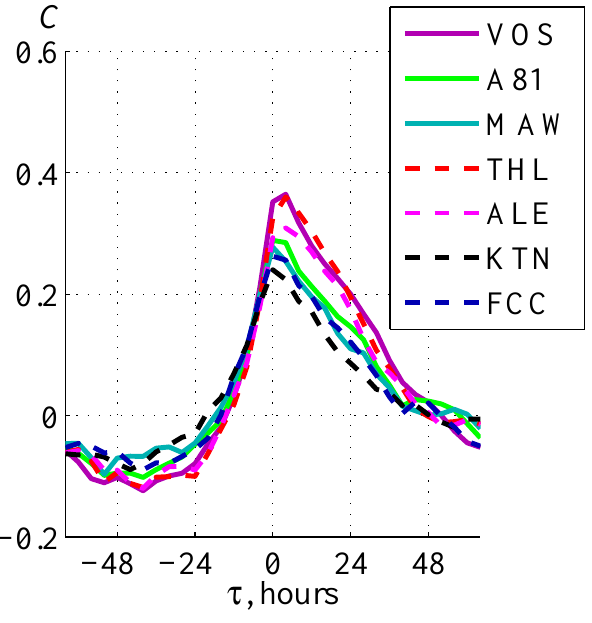
Fig. 9. The same as Fig. 8, but for the covariate functions S VOS − J (8 − 30keV), S P , P , and S Bz . Jumps in S VOS − S P covariate function are due to gaps in S P time